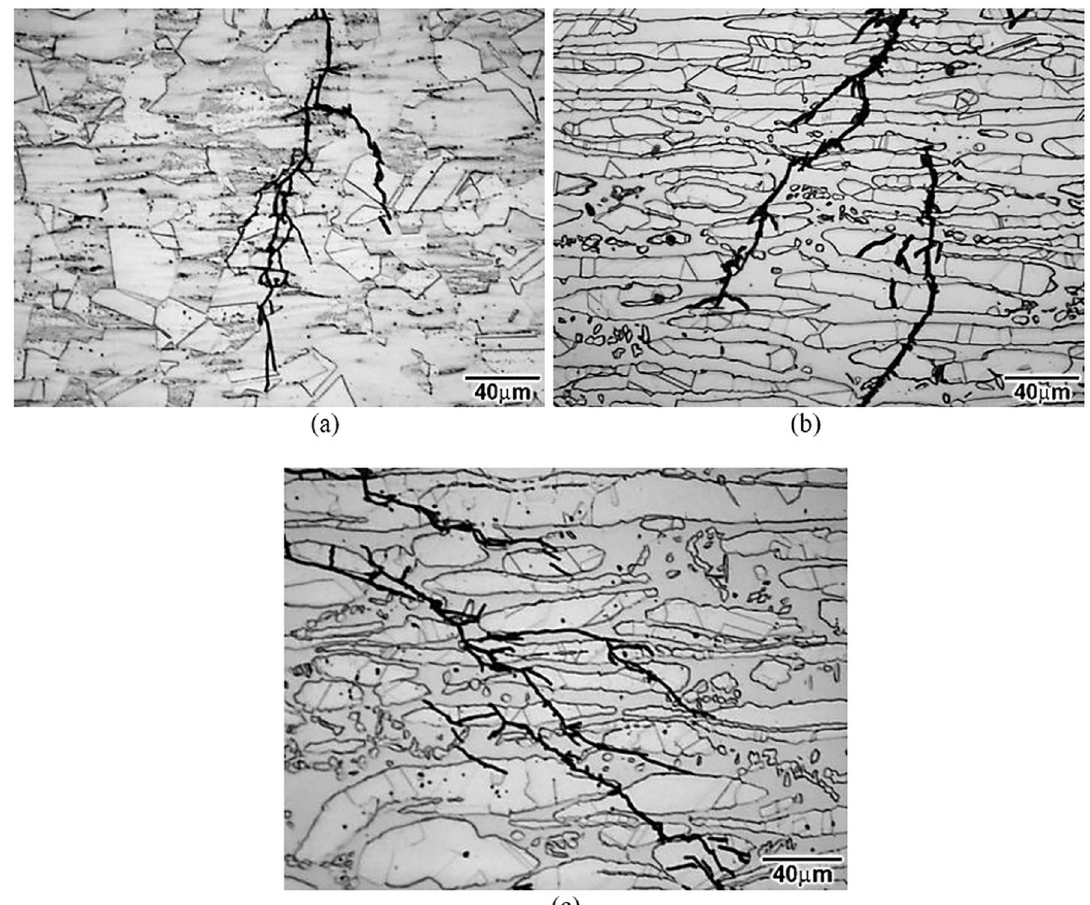
Figure 10. Propagation of the SCC along the microstructure after DET at 110 °C. (a) UNS S31603 ASS tested at 100 % of the yield stress (278 MPa); (b) UNS S32205 DSS tested at 100 % of the yield stress (473 MPa); (c) UNS S32750 SDSS tested at 100 % of the yield stress (589 MPa). Optical